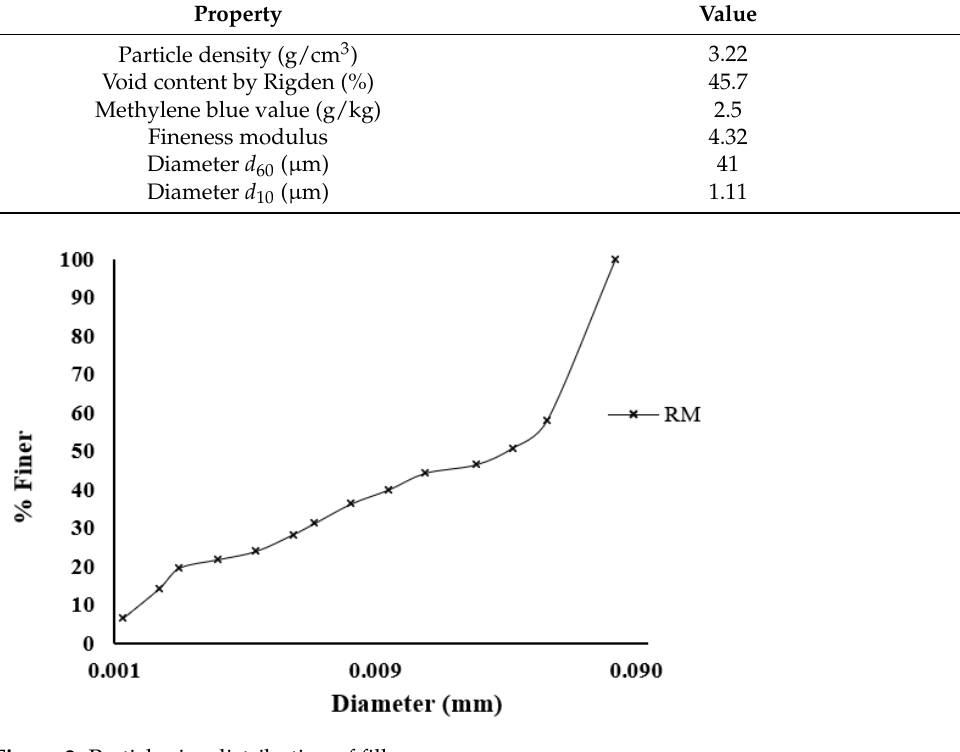
Figure 2. Particle size distribution of filler. Table 2. Basic properties of Table 1. Physical properties of filler.